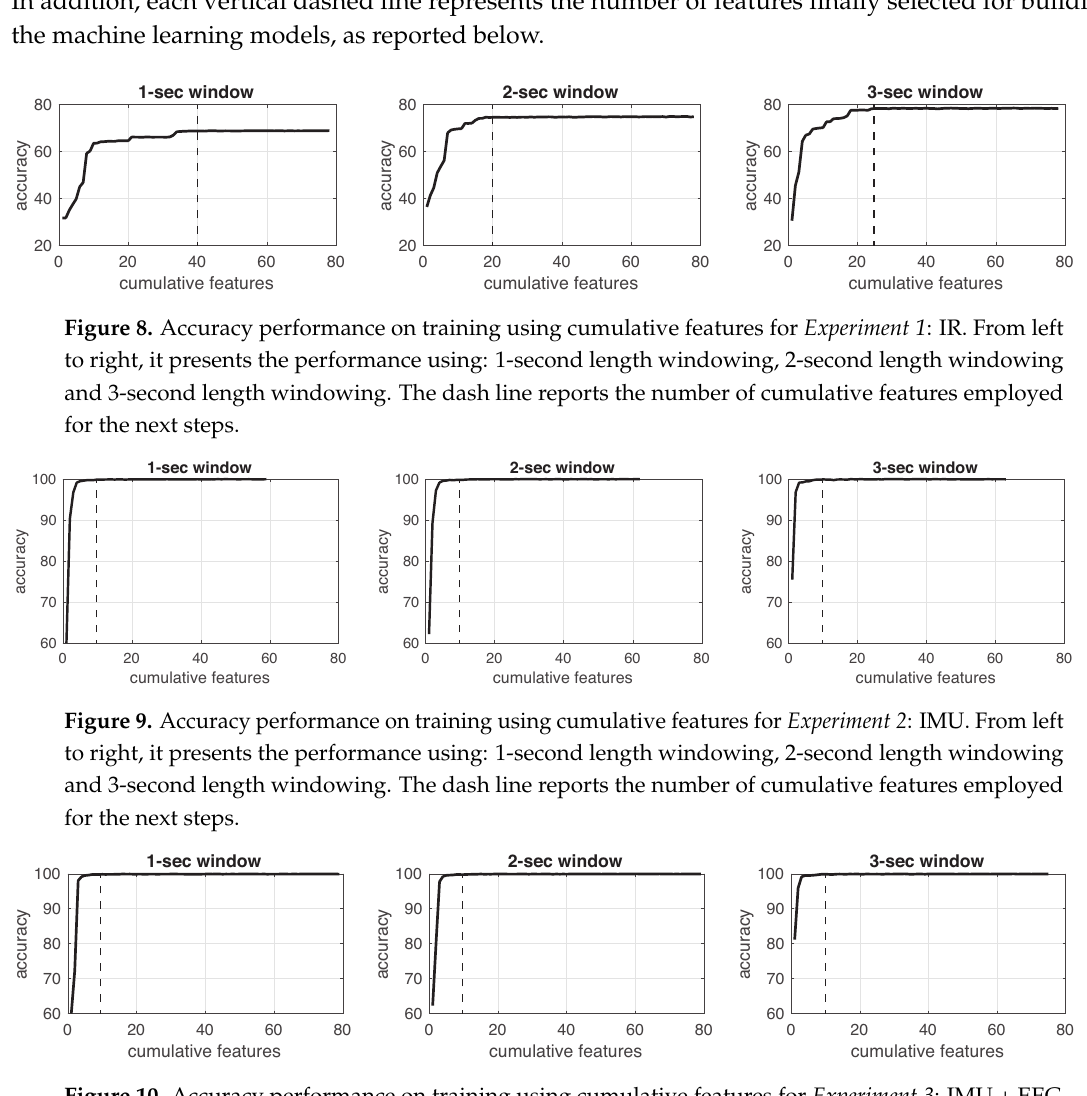
Figure 10. Accuracy performance on training using cumulative features for Experiment 3 : IMU + EEG. From left to right, it presents the performance using: 1-second length windowing, 2-second length windowing and 3-second length windowing. The dash line reports the number of cumulative features employed for the next steps.